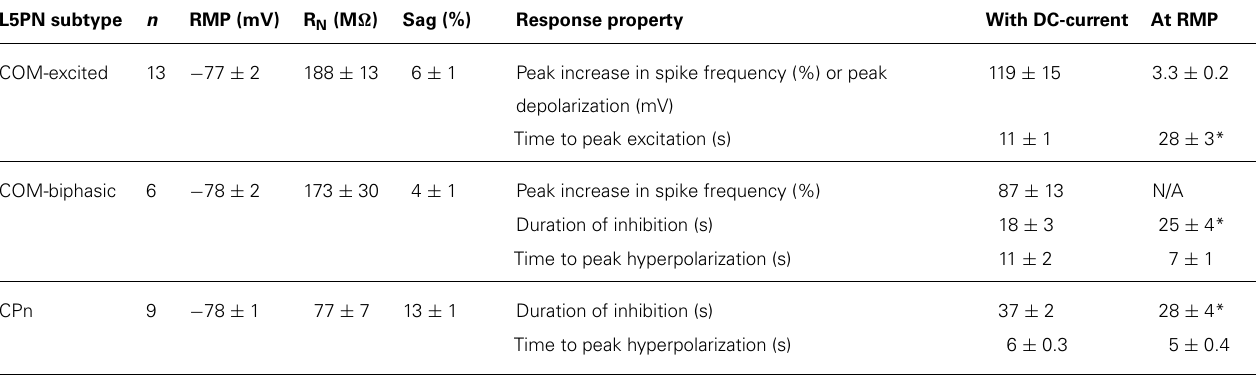
Table 1 | Properties of L5PN subtypes and their responses to